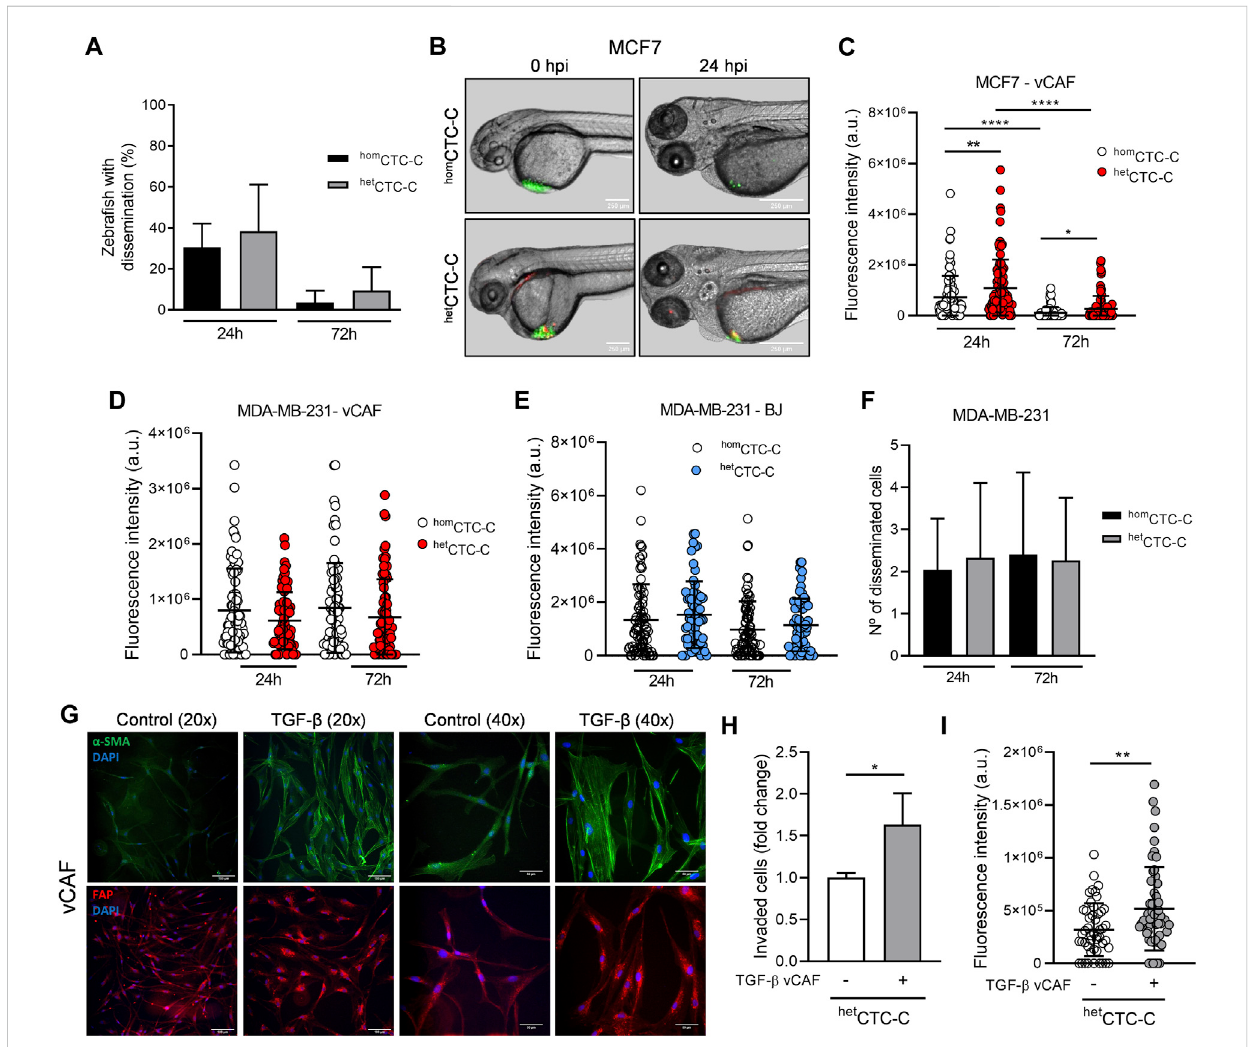
FIGURE 2 AssessingthemetastaticabilityofBC hom CTC-Cand het CTC-Cinthezebra fi sh. (A) Percentageof fi shxenograftedwithMCF7 hom CTC-Cand het CTC- C showing tumour cells dissemination in the tail 24 and 72 hpi; (B) Representative images of zebra fi sh showing hom CTC-C and het CTC-C from MCF7 (green)andvCAF(red)xenograftsintheDuctofCuvierrightafterinjection(0 hpi)and24 hpi(scalebar250 µm); (C) Dotplotofthe fl